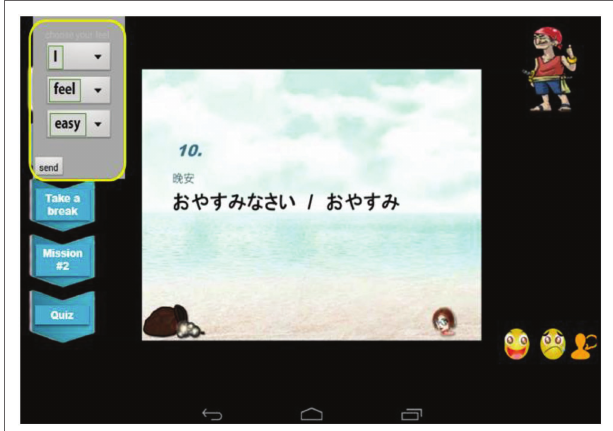
FIGURE 3 | Screenshot of our ATS and learning